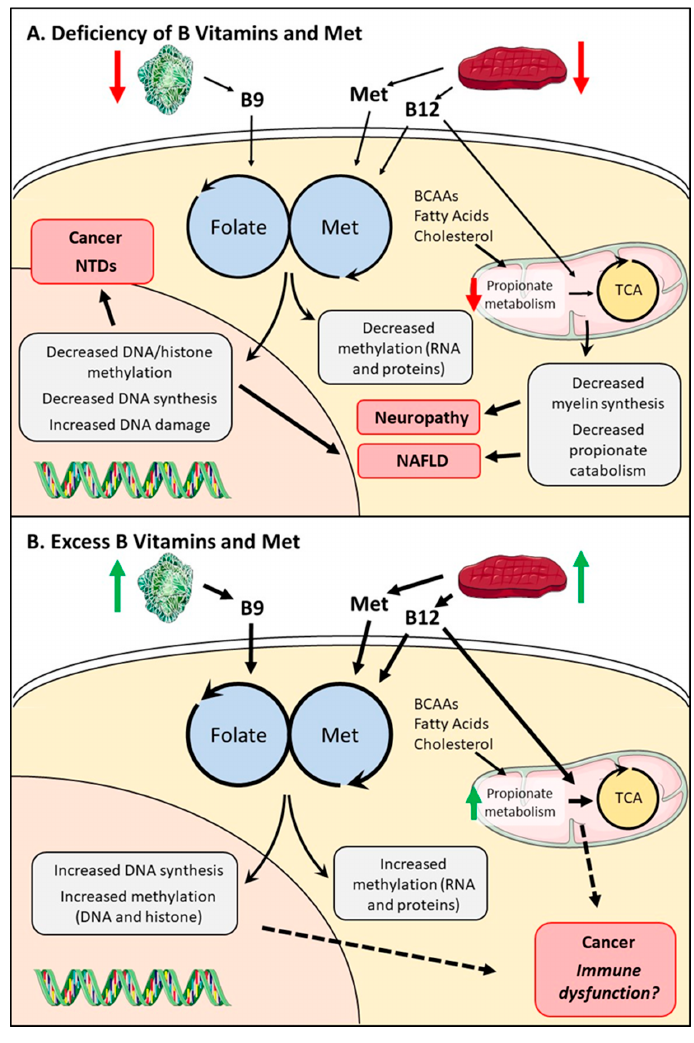
Figure 2. Systemic effects of altered micronutrients in one-carbon metabolism. ( A ) Reduced folate, methionine, or B12 can cause a decrease in one-carbon metabolism output, leading to decreased DNA synthesis, increased genomic instability, and decreased methylation potential. This can promote the development of neural tube defects (NTDs), non-alcoholic fatty liver disease (NAFLD), and cancer (specifically colorectal cancer). Reduced B12 also decreases activity of the propionate catabolic pathway through decreased methylmalonyl-CoA mutase (MUT) enzymatic activity, leading to decreased myelin synthesis, increased cellular stress, and disrupted tricarboxylic acid (TCA) cycling. These factors influence the development of neuropathies and promote NAFLD. ( B ) Effects of excess folate, methionine, and B12 are less understood, but increases can promote cell proliferation and can increase SAM (S-adenosylmethionine) levels, which allow cells to maintain their methylated states. This could lead to the development of cancers as maintenance of methylation is important for some malignancies. Excessivefolatealsodisruptsnormalhematopoiesis,